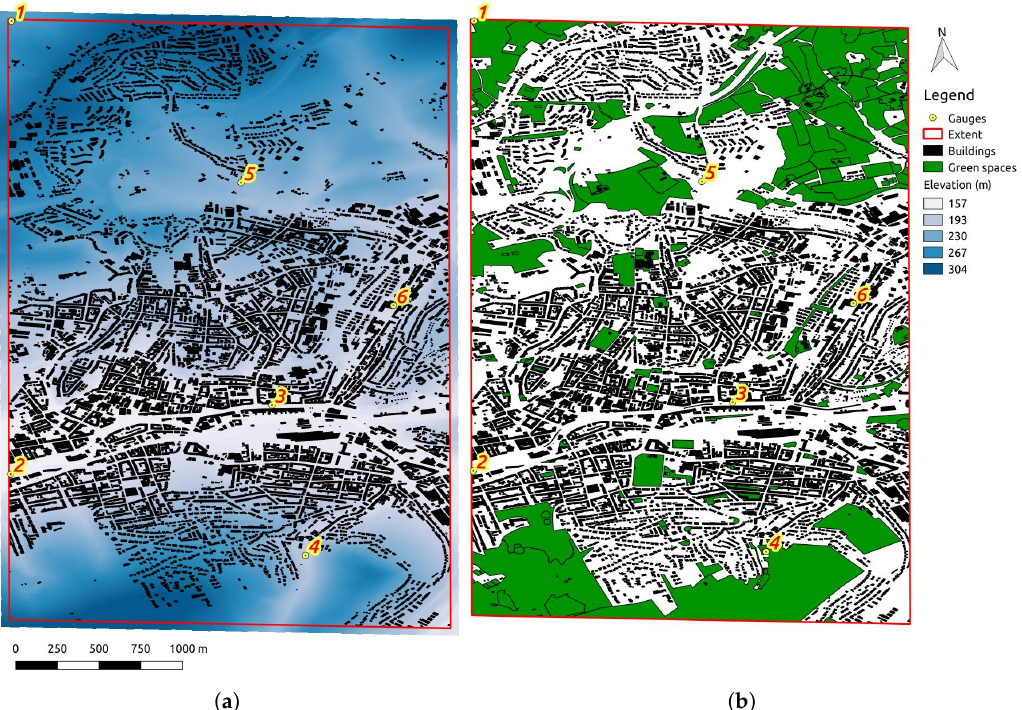
Figure 4. Case study data for an urban area in Wuppertal: ( a ) DEM; ( b ) Land cover.